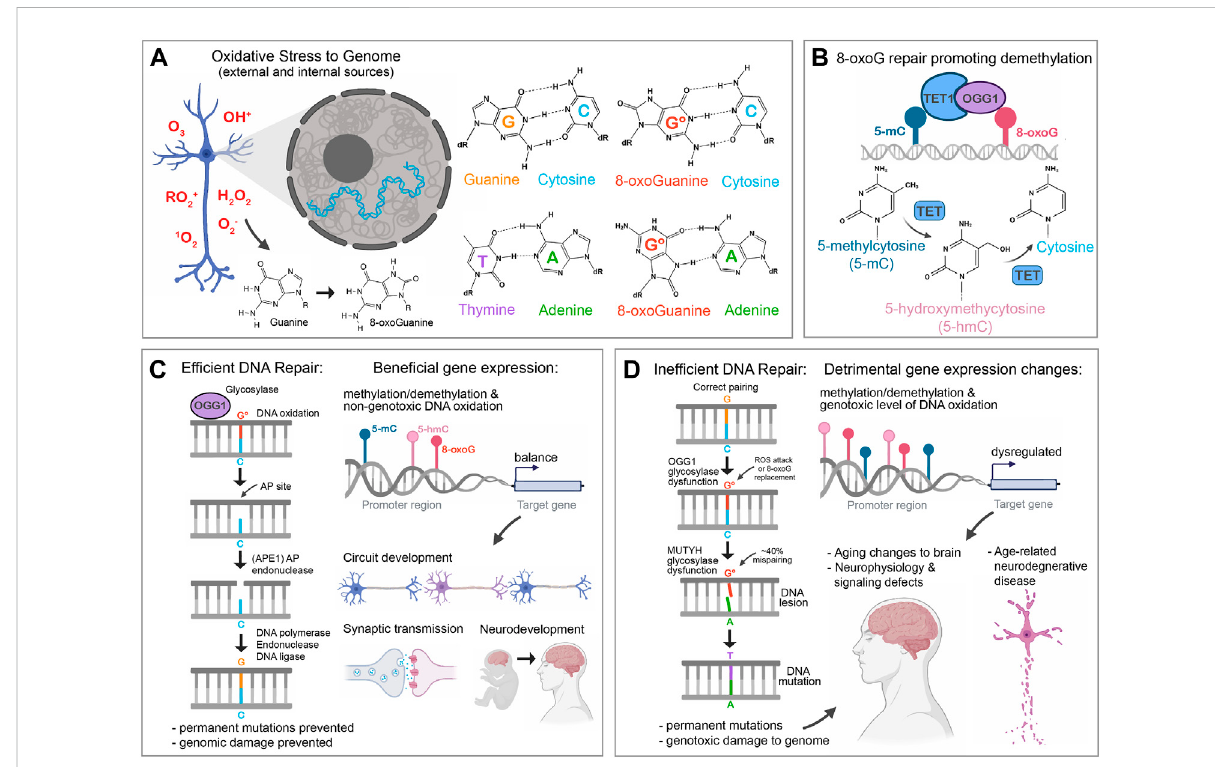
FIGURE 1 Thebene fi cialanddetrimentalsidesof8-oxoGonthegenomeandgeneexpression. (A) .Oxidativestressmoleculescanchangenucleotidesby adding oxygen to the molecular structure, such as turning guanine into 8-oxoguanine (8-oxoG). This can occur to free nucleotides, which later intercalateintoDNA,orviadirectattackofguanosineinDNA.8-oxoGcaneasilypairwithcytosine,whichisindistinguishablefromanormalguanine- cytosinepairing.8-oxopreferstopairwithcytosine,butstericallycanformaHoogsteenbasepairwithadenine.An8-oxoG-adeninemispairing is unstable, with adenine preferring to pair with thymine. (B) . The presence of 8-oxoG can indirectly promote the demethylation of nearby methylated cytosine (5-mC), via OGG1. OGG1 is the glycosylase in charge of removing 8-oxoG from DNA, but can also partner with TET1, and enhance its enzymatic activity as promoting 5-mC demethylation into forms such as 5-hmC which can promote gene expression changes via epigenetic mechanisms. (C) . In a well-regulated system, the presence of 8-oxoG in the genome is ef fi ciently removed from the DNA via the Base Excision Repair pathway. Once 8-oxoG is excised from the DNA, molecules such as APE1 continue to fi x the resulting AP site by nicking the phosphate backbone and initiating polymerase-based repair. Thus, the genome is protected from permanent somatic mutational damage. 8-oxoG in such a robust repair environment is limited to having a temporary presence in DNA, which can potentially promote brief changes in OGG1- > TET methylation changes and activation in gene promoters. This can promote the gene expression changes found to be essential in many neurodevelopmental events, such as gross brain development, neuron maturation, circuit development, and synaptic function. It should be noted thatinadditiontoBER,theNERproteins,canplayaroleinclearing8-oxoGusingglycosylaseenzymeslikeOGG1(Kumaretal.,2022). (D) .Inacellular environment with excess oxidative stress, increased 8-oxoG can overwhelm repair machinery. The longer perdurance of 8-oxoG can lead to a greater chance at mispairing with adenine at a rate of ~30%. This 8-oxoG-adenine lesion can result in the establishment of a permanent